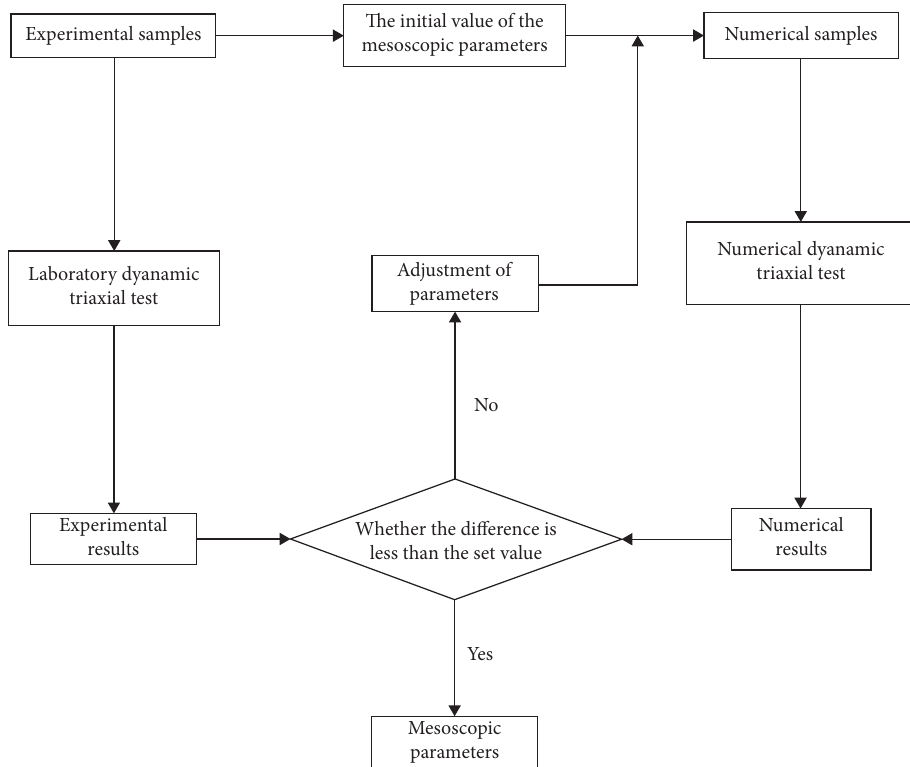
Figure 5: Calibration process of mesoscopic parameters of coarse-grained